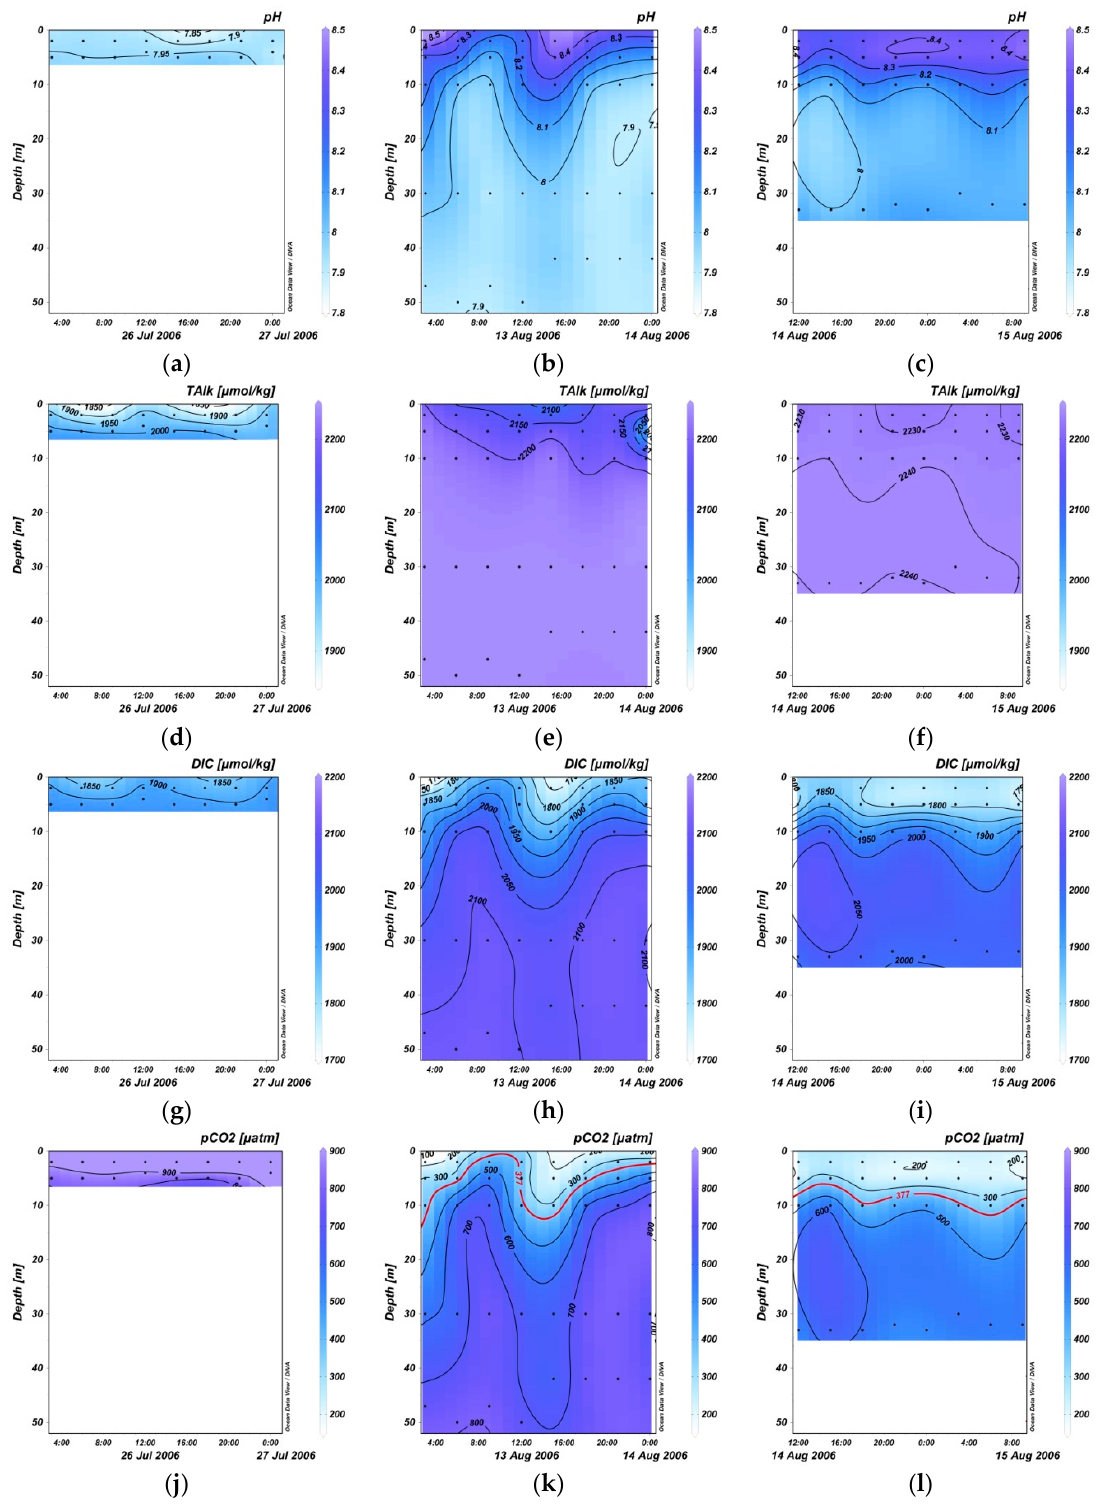
Figure 4. Twenty-four hour variations in pH in the near-shore ( a ), front ( b ), and offshore ( c ) regions; TA in the near-shore ( d ), front ( e ), and offshore ( f ) regions; DIC in the near-shore ( g ), front ( h ), and offshore ( i ) regions; and sea surface p CO 2 in the near-shore ( j ), front ( k ), and offshore ( l ) regions in summer.